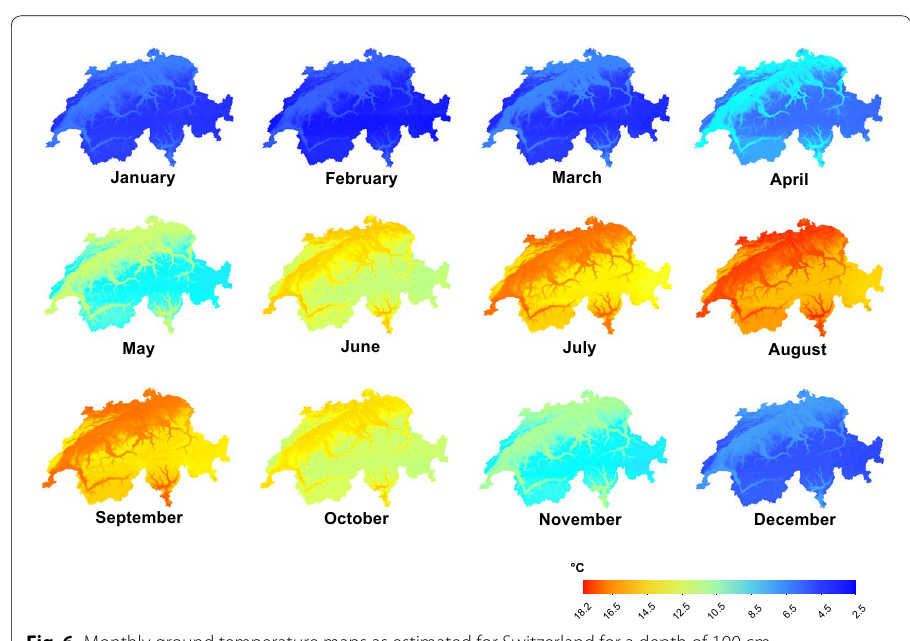
Fig. 6 Monthly ground temperature maps as estimated for Switzerland for a depth of 100